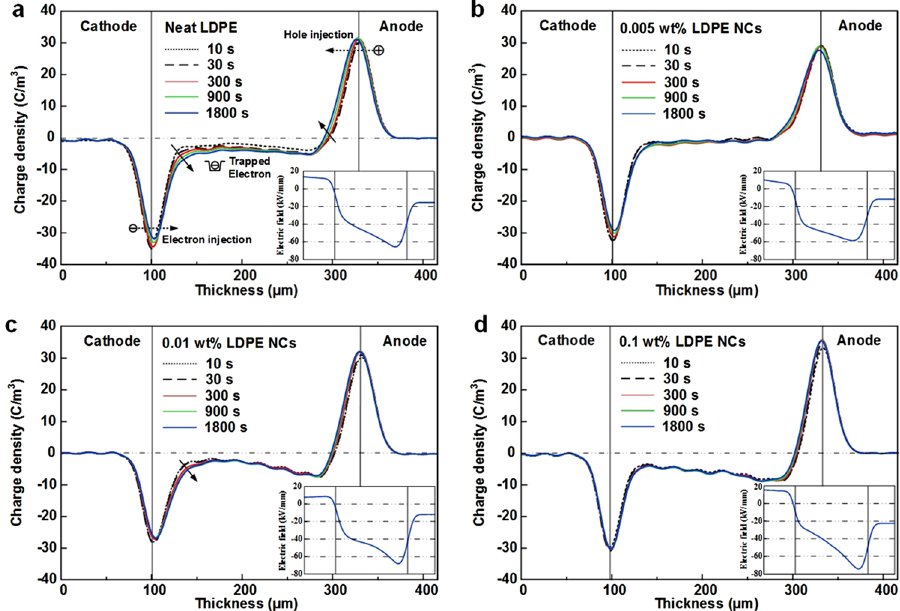
Figure 3. Space charge behaviors LDPE/graphene NCs under 50 kV/mm measured by PEA method, as well as the electric field distribution after applying the stress for 1800 s. ( a ) Neat LDPE. ( b ) 0.005 wt% LDPE NCs. ( c